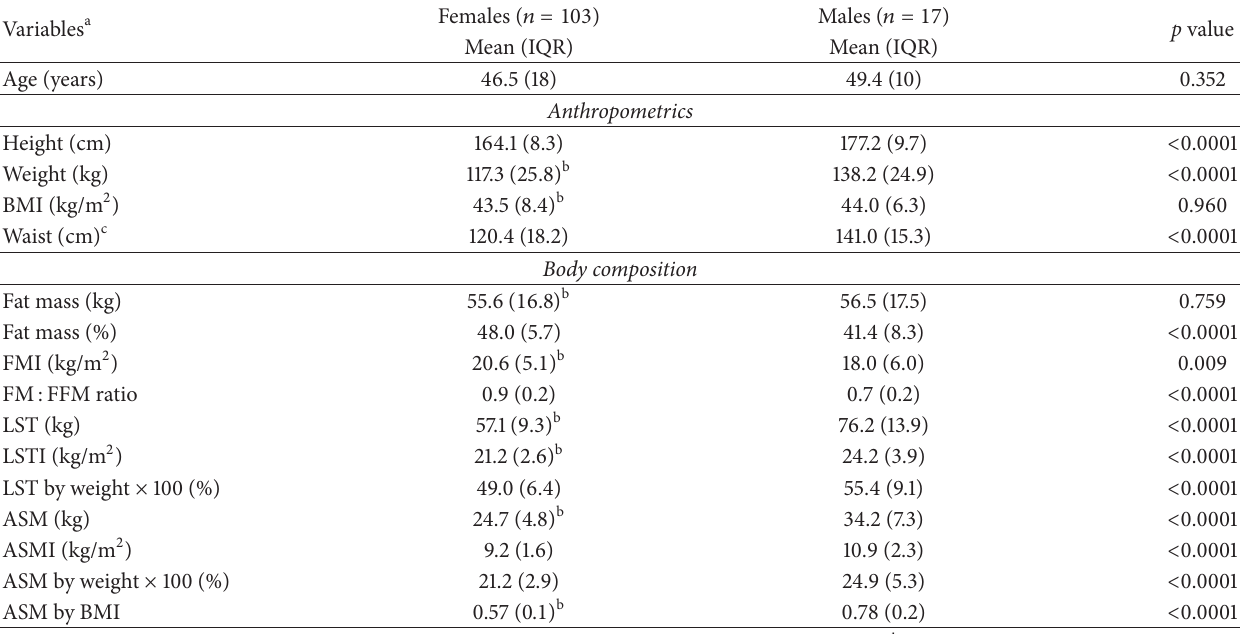
Table 3: Subject characteristics, anthropometrics, and body composition ( 𝑛 = 120 ), by sex.